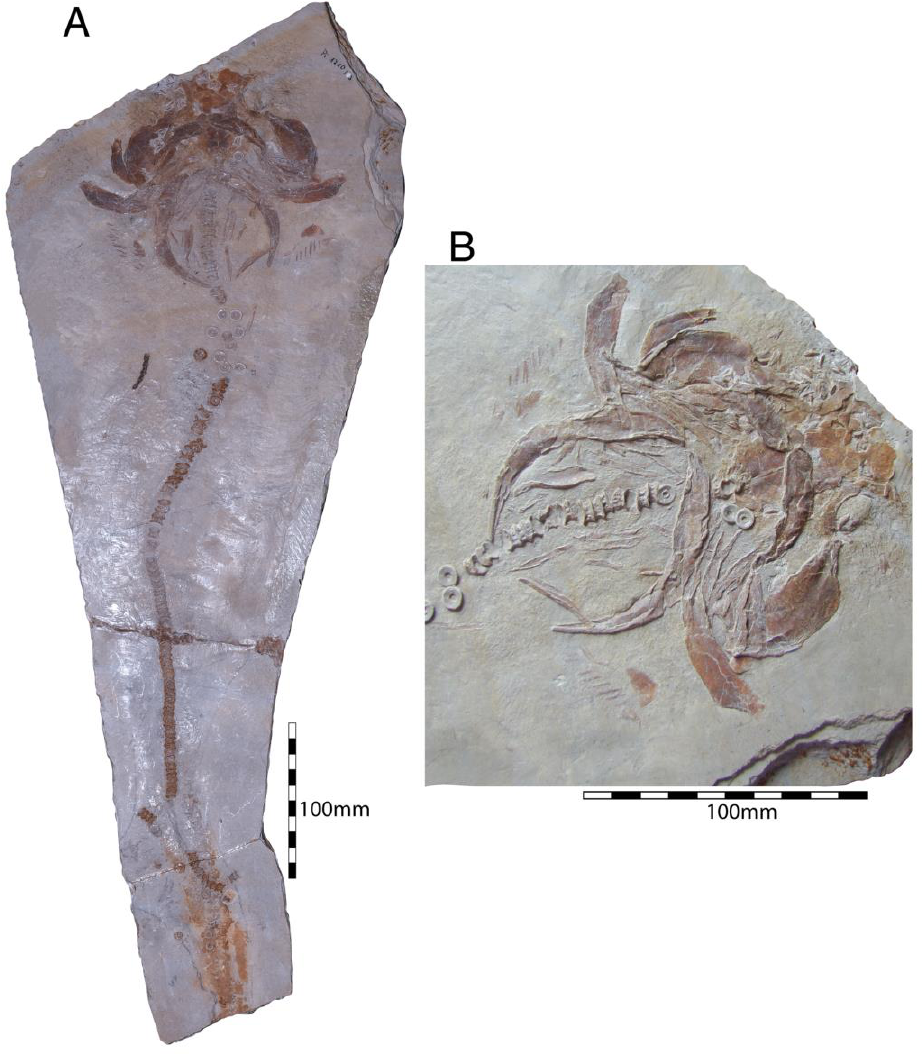
Figure 28. † Notidanoides muensteri (Agassiz, 1843 [170]) . ( A ) Incomplete specimen (GPIT Pi 1210/3) from the Kimmeridgian of Nusplingen. ( B ) Close up of the cephalic region.